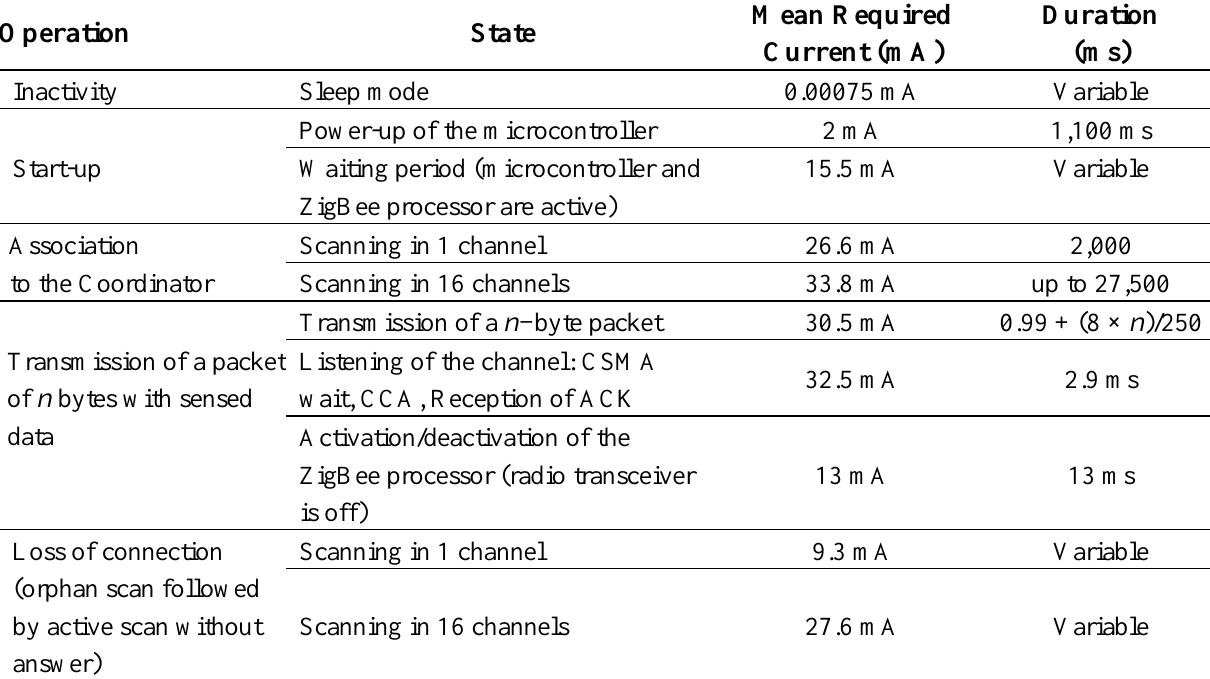
Table 1. Summary of drained current for different 802.15.4/ZigBee operations in the CC2480